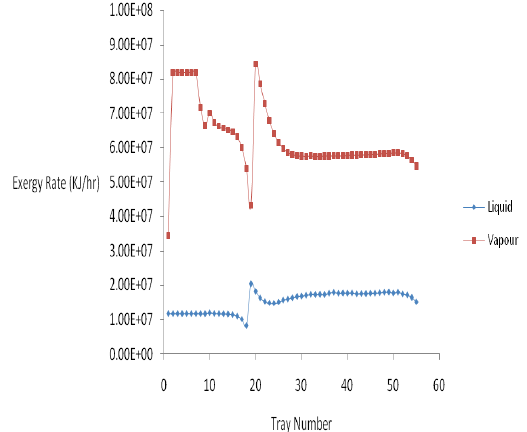
Figure 27. Profile of exergy rate versus tray number for Depropanizer of base 800KPa case